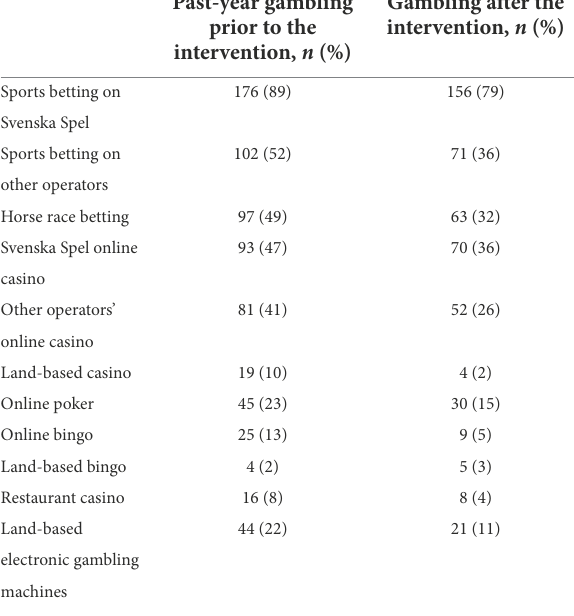
TABLE 2 Self-reported gambling patterns for the past year prior to the intervention, and for the time period between the intervention and the survey (approximately 10 days), respectively ( N =